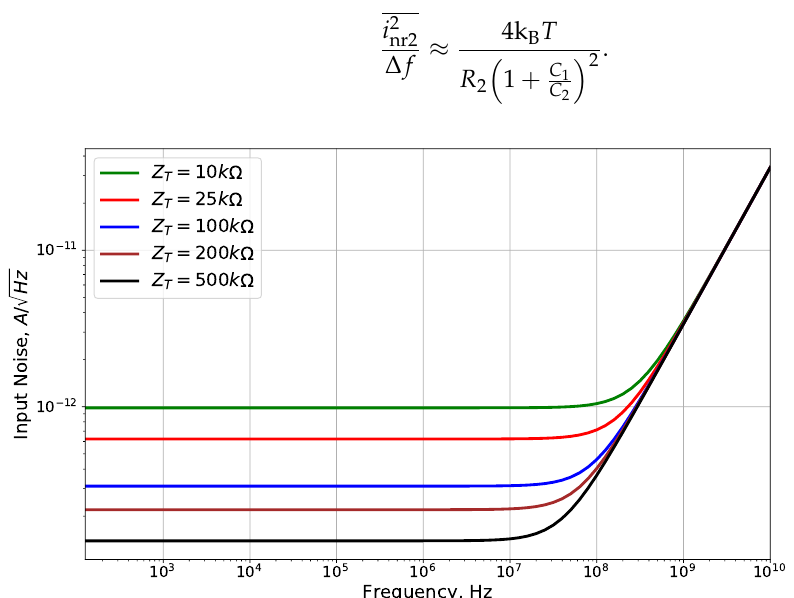
Figure 4. Analytically calculated input-referred noise model for programmable-gain configuration with M 1 thermal noise component and noise due to R bias,1 (example case for TSMC 0.18 µ m CMOS).